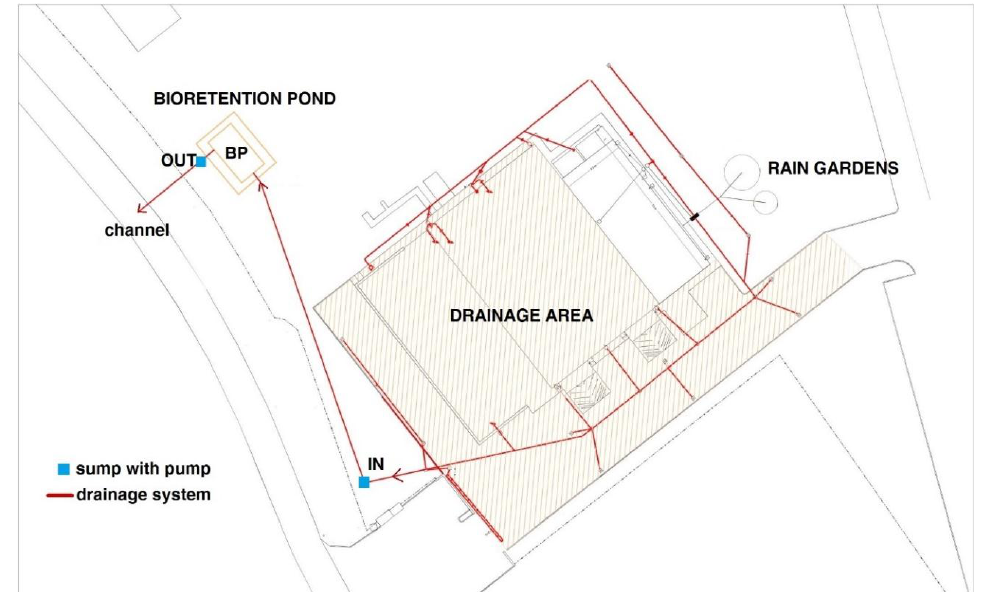
Figure 2. Plan of the experimental area with the position of the bioretention pond (BP) and the sumps where the water samples were collected (BP, IN, OUT). The rainwater drainage system with the path of water from storm drains is also reported. The overflow water was collected in the inflow sump (IN) and pumped in the BP; from the outflow sump (OUT), the water was pumped in a channel of the urban surface drainage system.